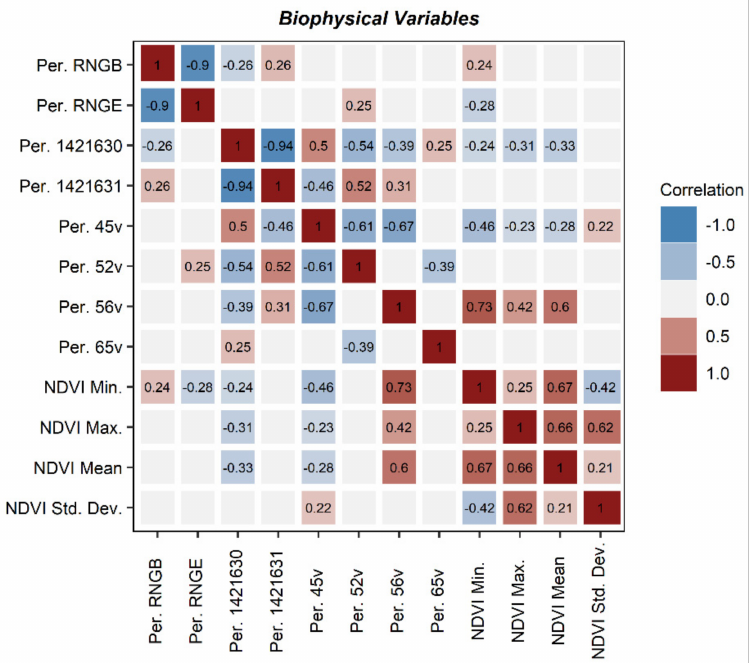
Figure 3. Correlations between the full list of biophysical variables from − 1 (blue) to 1 (red). Non- significant correlations ( p -value > 0.05) were removed.